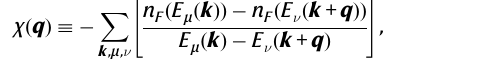
(SD-2) phase with respect to the pristine structure. b Phonon bands of monolayer KV 3 Sb 5 in theISD-1phase.Inthe inset,the solid and dashedlinesrepresent theBZs ffiffiffi p for the 2×2 and 3 ×1 structures, respectively. For Rb and Cs, see Supplemen- tary Fig. S4.